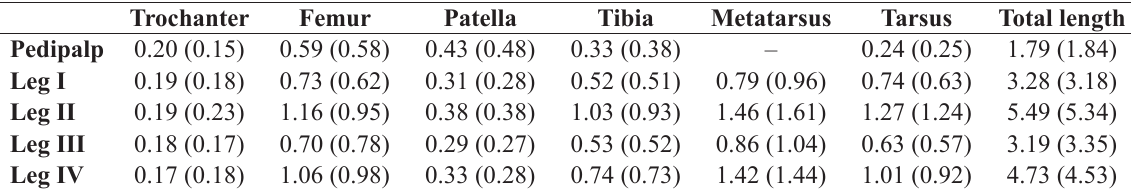
Table 12. Length of appendage-segments in millimeters in Nemastoma bidentatum sneznikensis ssp. nov. from Mt. Snežnik, Slovenia: ♂ holotype